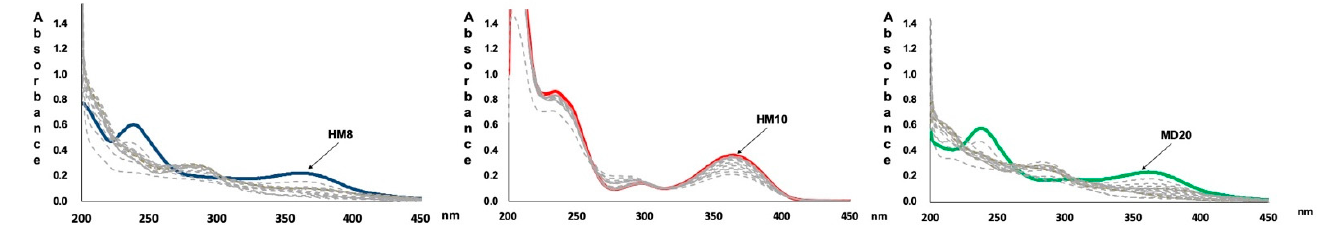
Figure 3. UV spectra recorded along the photodegradation test on the ethanol solutions of HM8, HM10 and MD20.